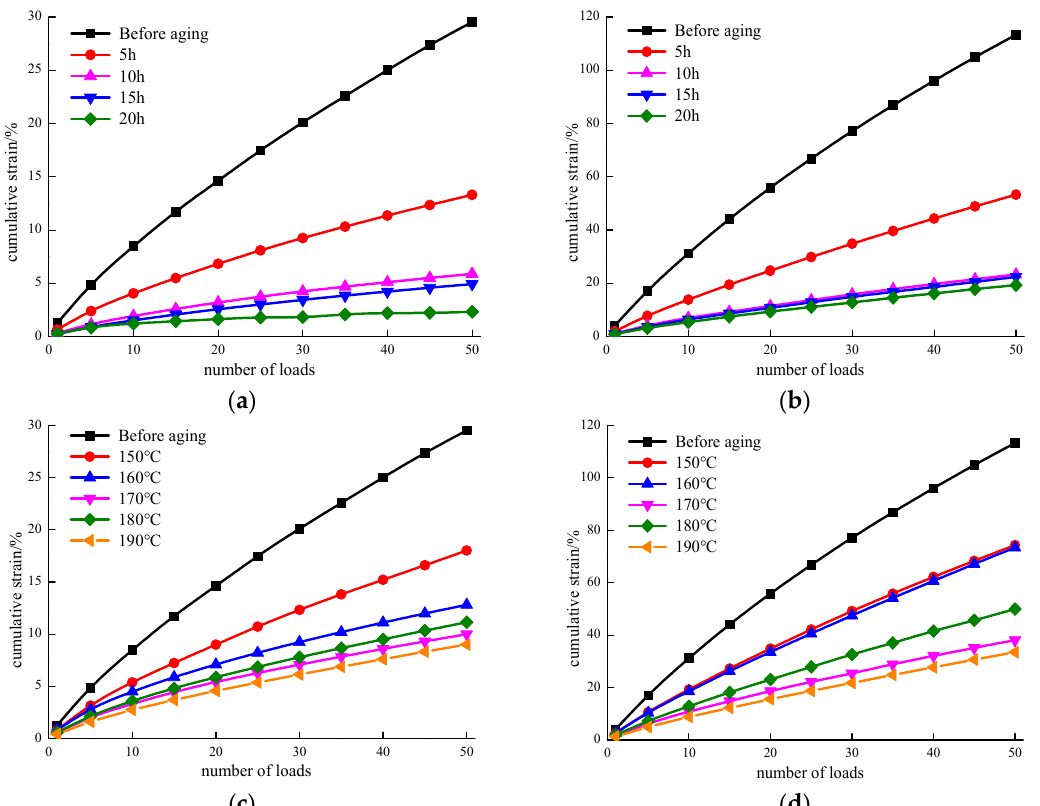
Figure 9. Relationship between cumulative strain of asphalt and number of loading times: ( a ) different aging time at 100 Pa ; ( b ) different aging time at 300 Pa ; ( c ) different aging temperature at 100 Pa ; and ( d ) different aging temperature at 300 Pa .